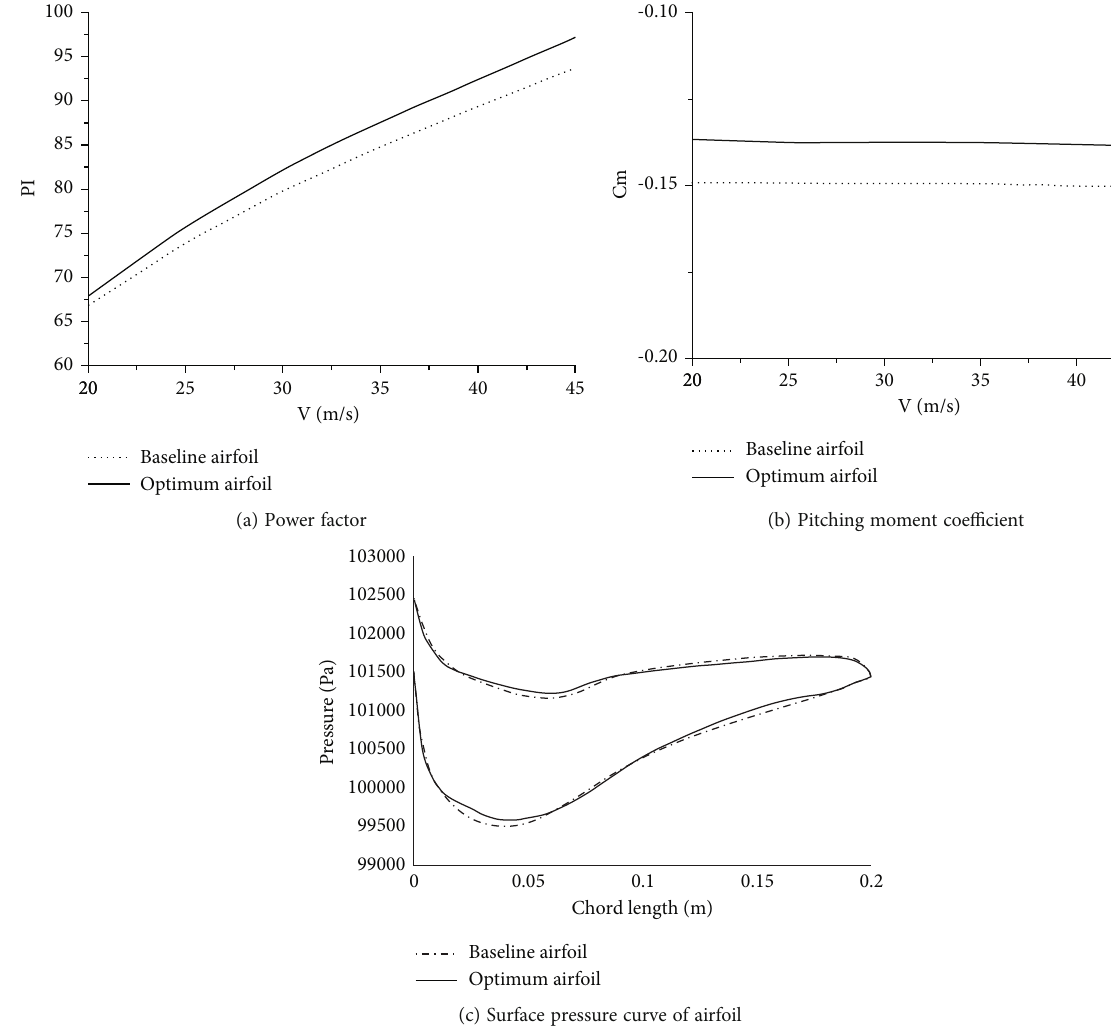
Figure 12: Aerodynamic characteristics of airfoil with